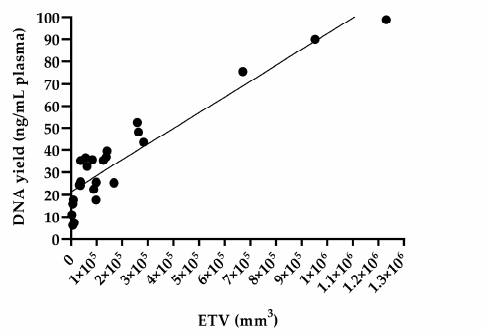
Figure 2. Association between estimated tumor volume (ETV) and tumor-derived circulating cell-free DNA yield. Pearson correlation coefficient was showed a significant correlation ( r = 0.9326, p < 0.0001, 95% confidence interval: 0.8510 to 0.9702). 3.4. NGS-Based Mutation Profiling of Genomic and Cell-Free DNA TVB was defined with the number of gene variants including SNPs above 2% VAF (Figure 3). TVB was calculated in tissue and liquid biopsy samples, as well. The largest TVB was in cases 2, 18, and 23, while no nucleotide change was detected in cases 1, 17, and 19. In cases 12 and 20, only the liquid biopsy was informative for the aspect of tumor burden determination. Comparing tissue and LB results, similar TVB was observed in most of the cases. When comparing average TVB of the three BTC subtypes, no significant difference was identified (tissue vs. LB in IHCC: 2.1 vs. 1.6, p = 0.3612; tissue vs. LB in EHCC: 1.4 vs. 0.8, p = 0.6374; tissue vs. LB in GBC: 3.8 vs. 2.4, p = 0.2371). No significant difference was observed, comparing tissue biopsy-derived TVB (IHCC vs. EHCC: p = 0.5166; IHCC vs. GBC: p = 0.1154, EHCC vs. GBC: p = 0.1281) and LB-derived TVB (IHCC vs. EHCC: p = 0.122; IHCC vs. GBC: p = 0.2034, EHCC vs. GBC: p = 0.0922), as well. SNVs were detected in 21/25 patients (84%), while in cases 1, 5, 17, and 19, nucleotide aberration was not identified by our method. In two cases, only the LB sample was in- formative for molecular analysis (tissue biopsy insufficient for molecular analysis, case 12 and 20). Detected SNVs and their clinical significance were presented in Table 3. The DNA VAF of tissue biopsy and LB were greatly varying with the average of 21.8% (range: 3.0–62.6) and 13.32% (range: 2.1–67.5), respectively. Pathogenic variations were proven at a rate of 17/25 (68%) and presented in some of the most usually affected genes in BTCs, such as FGFR2 , IDH1 , IDH2 , KRAS , and TP53 , and most of them could be identified in matched LB-originated cfDNA. Pathogenic SNVs were referred to as muta- tions ( n = 28 in the 25 patients), while benign aberrations were considered neutral ( n = 15).